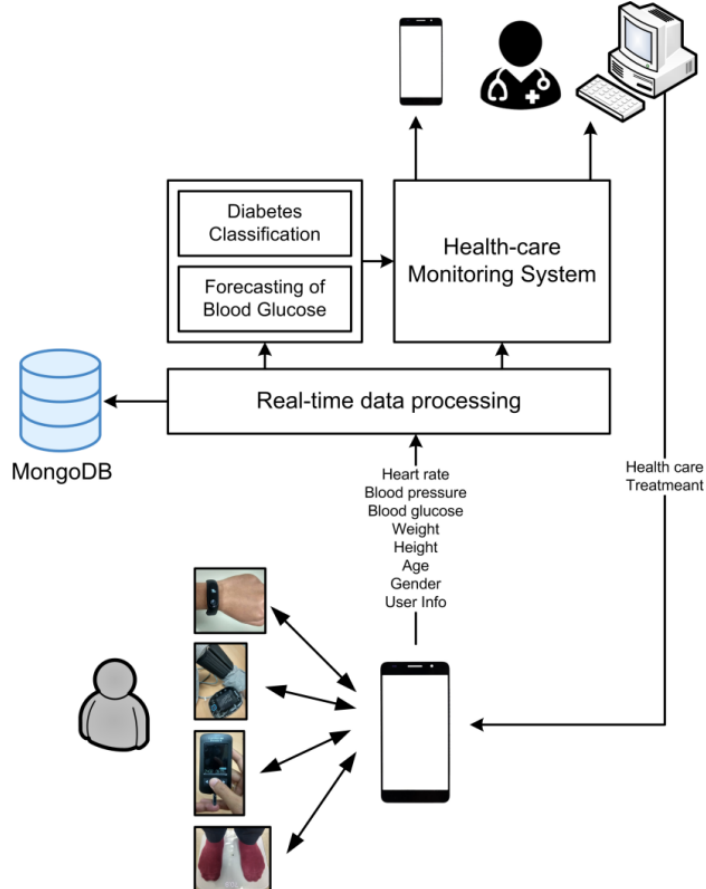
Figure 1. The architecture of the personalized healthcare monitoring system for diabetic patients.